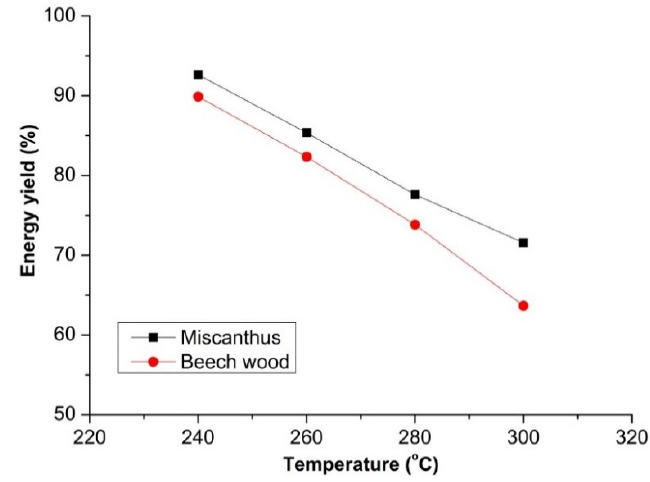
Figure 12. Energy yield profile of torrefied beech wood and miscanthus vs. temperature for a residence time of 30